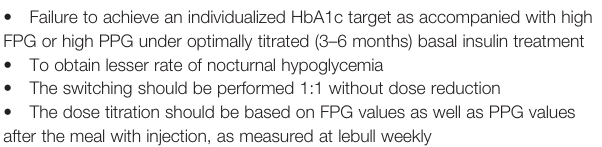
TABLE 3 | Expert Panel Recommendation 3: Switching from basal insulin.